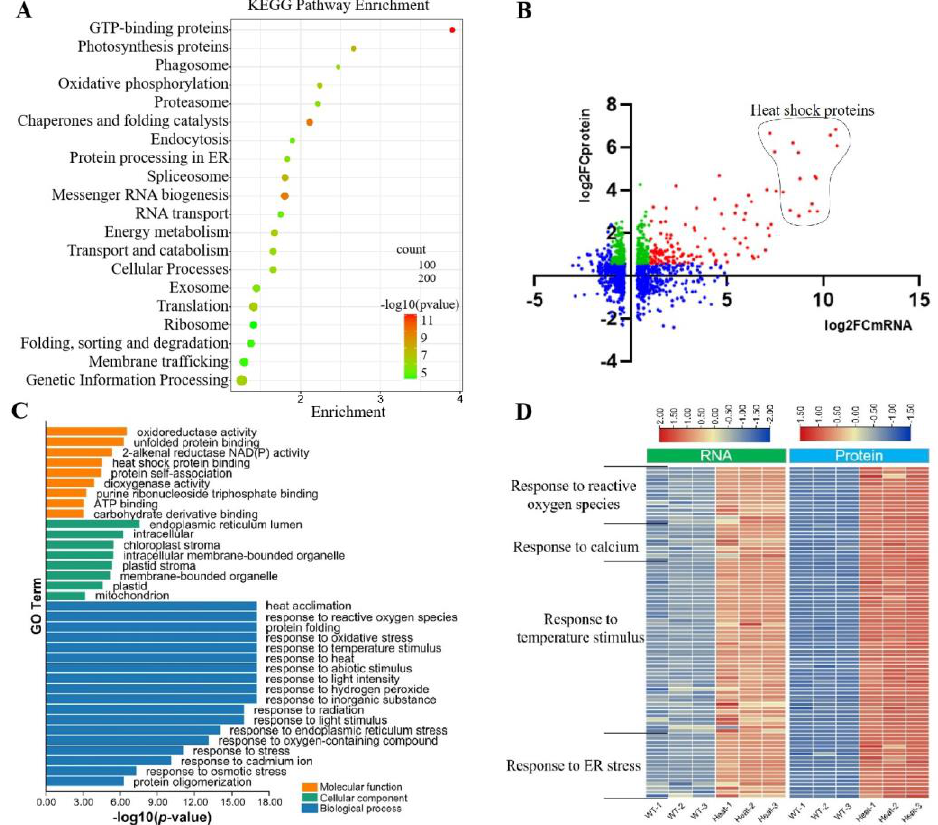
Figure 4. Integrative analyses of proteome and transcriptome on heat−treated maize: ( A ) KEGG analysis of the DEPs. Proteins are prepared from the ER; ( B ) coordination analysis of the proteomics and transcription data. The x and y axes represent the Log 2 FC of RNAseq and proteomics, respec- tively; ( C ) GO analysis of the genes simultaneously up − regulated at RNA and protein levels; and ( D ) heat maps of up−regulated DEGs for four major pathways.